Question: Express in one sentence what the figure is showing.
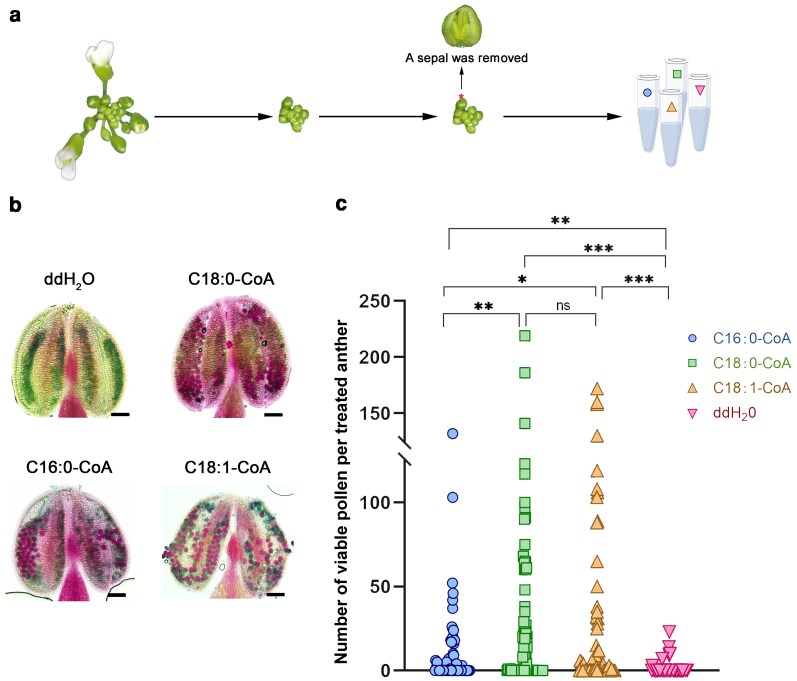
Answer: C16:0-CoA, C18:0-CoA, and C18:1-CoA supplementation partially rescues the npu-2 sterility phenotype. a) Schematic representation of the experimental procedure. Flower buds containing Stage 7 to 8 anthers (denoted by a small red star) were selected, and one sepal was removed to facilitate solution penetration. The treated inflorescences were immersed in different acyl-CoA solutions or water (control) for 10 s; this immersion was repeated 3 times daily for 3 d before Alexander staining. b) Representative images of anthers from each treatment group. Pollen viability was partially rescued by C16:0-CoA, C18:0-CoA, and C18:1-CoA treatment. Scale bar = 50 μm. c) Scatter plot showing the number of viable pollen grains per anther in each treatment group ( n > 60 anthers per group). Statistical significance between groups was determined using a two-tailed t -test (* P < 0.05; ** P < 0.01; *** P < 0.001; ns, no significant differences).